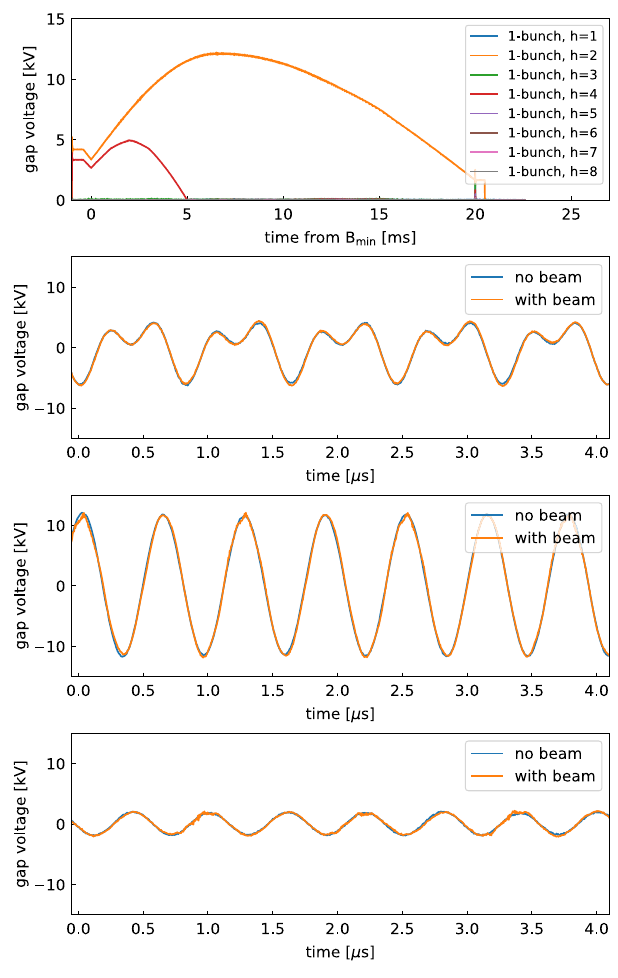
FIG. 36. (Top) Amplitudes of the harmonic components with acceleration of a single bunch at 3 . 1 × 10 13 ppp from injection to extraction and (second top to bottom) comparison of the gap voltage waveforms without and with a beam at 0, 10, and 19.9